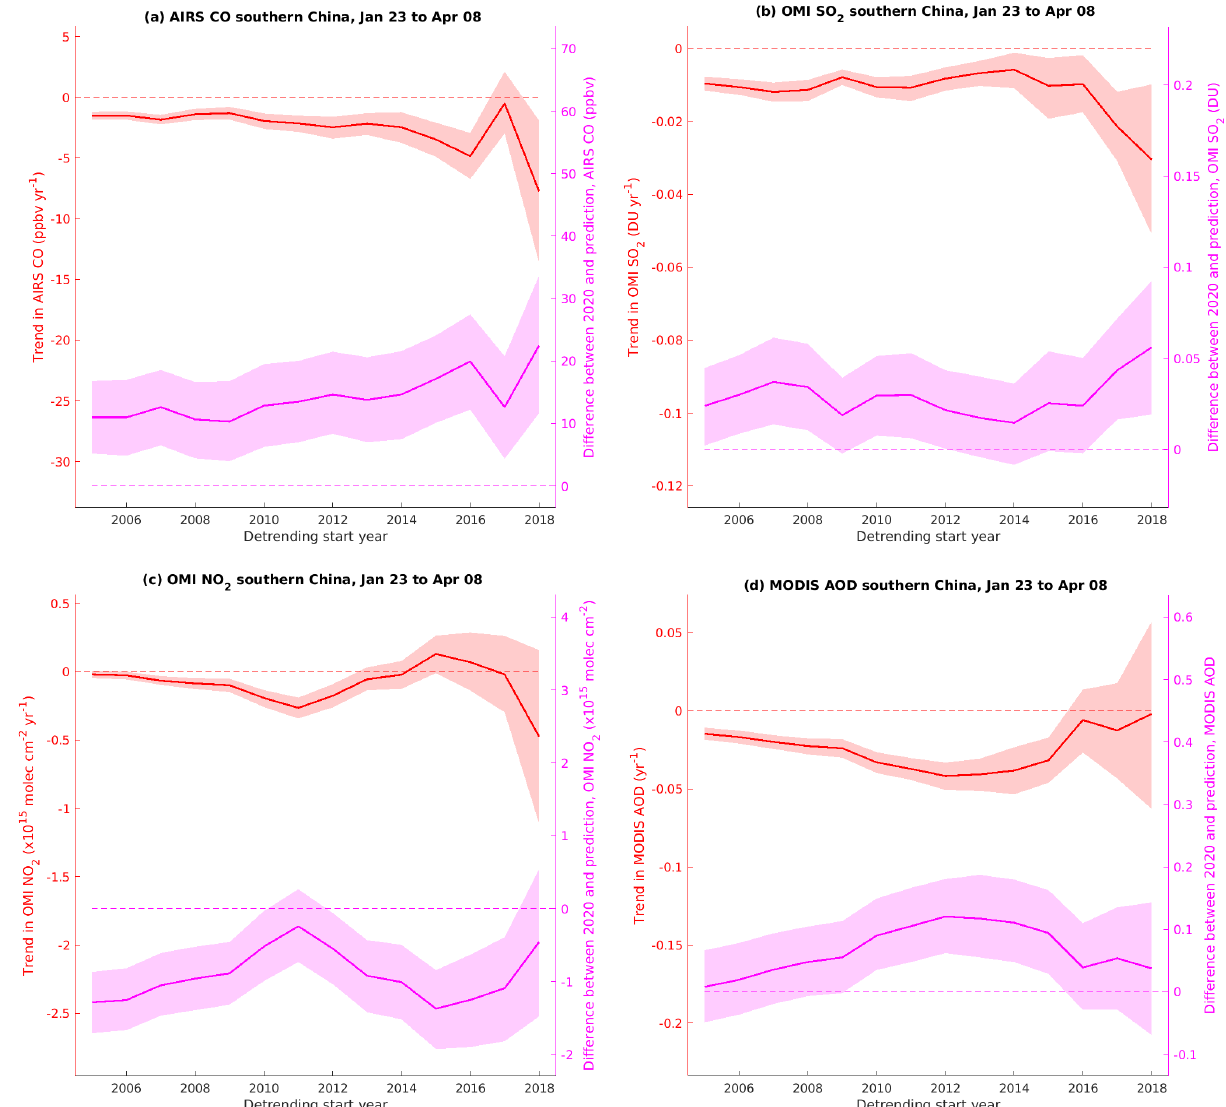
Figure 8. Same as Fig. 6 but for southern